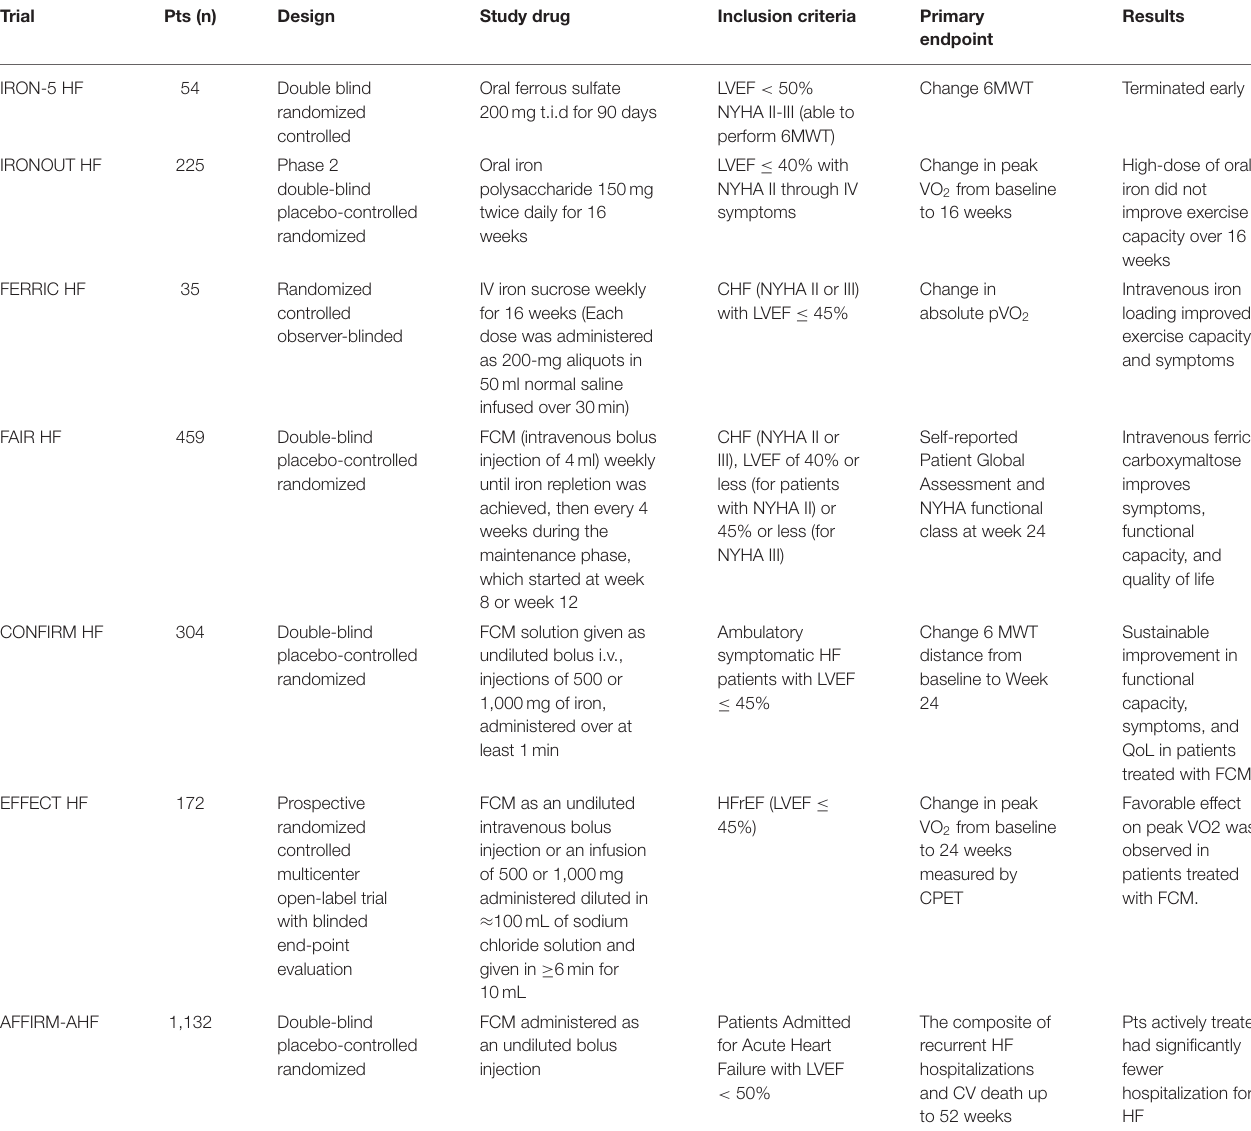
TABLE 1 | Main trials of iron supplementation in heart